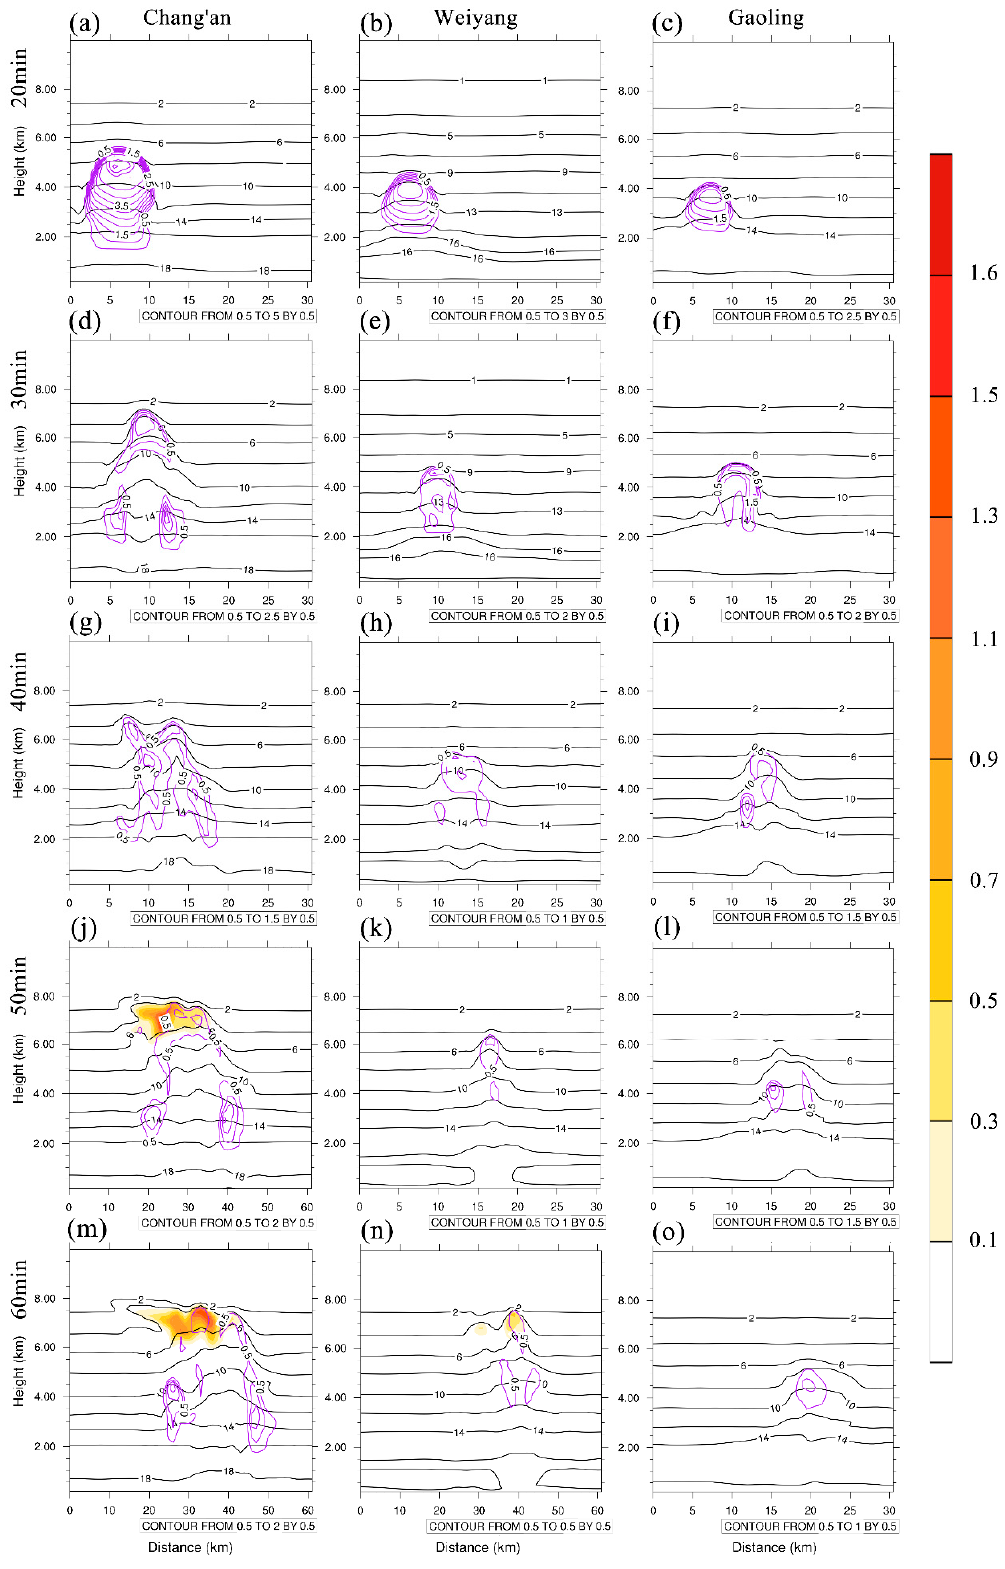
Figure 11. As shown in Figure 10, but for the profiles of water vapor mixing ratio (black line), clouds (purple line), and ice (filled color). Units are g/kg (mg/kg for ice). ( w here ( a – c ) are 20min, ( d – f ) are 30min, ( g – i ) are 40min, ( j – l ) are 50min, ( m – o ) are 60min. ( a , d , g , j , m ) are Chang'an District; ( b , e , h , k , n ) are Weiyang District; ( c , f , i , l , o ) are Gaoling District).